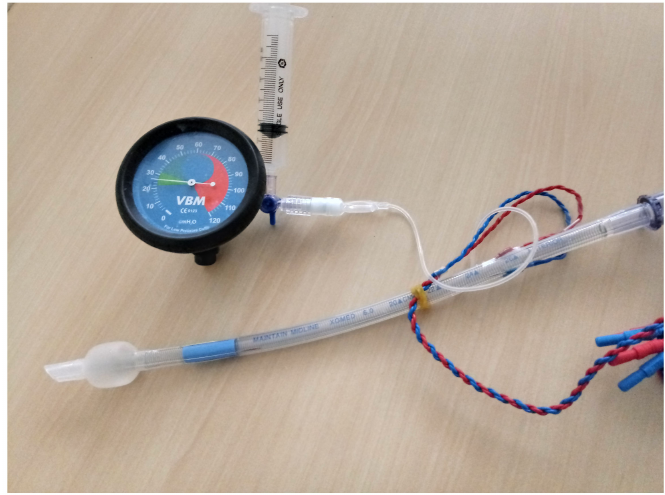
Figure 1. Cu ff pressure measurement system. The cu ff pressure was continuously monitored using a manometer. The pilot balloon of the endotracheal tube was connected to the manometer via a 3-way stopcock. Air was injected into or withdrawn from the pilot balloon using a 10-mL syringe via a side port on the